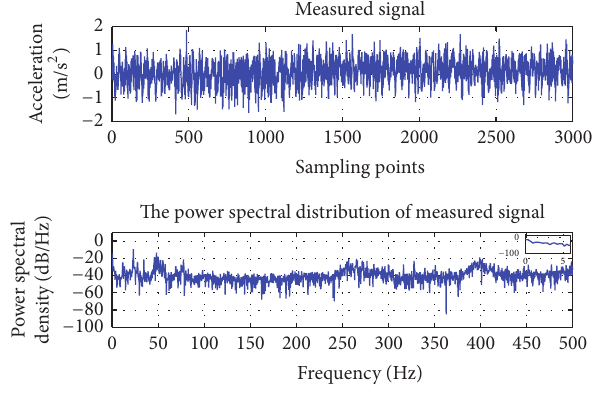
Table 2: The SNR and RMSE results of denoising methods.